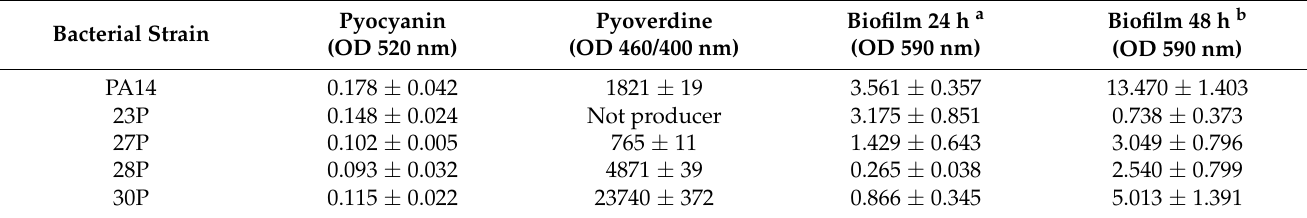
Table 2. Phenotypic features of clinical and PA14 strains.